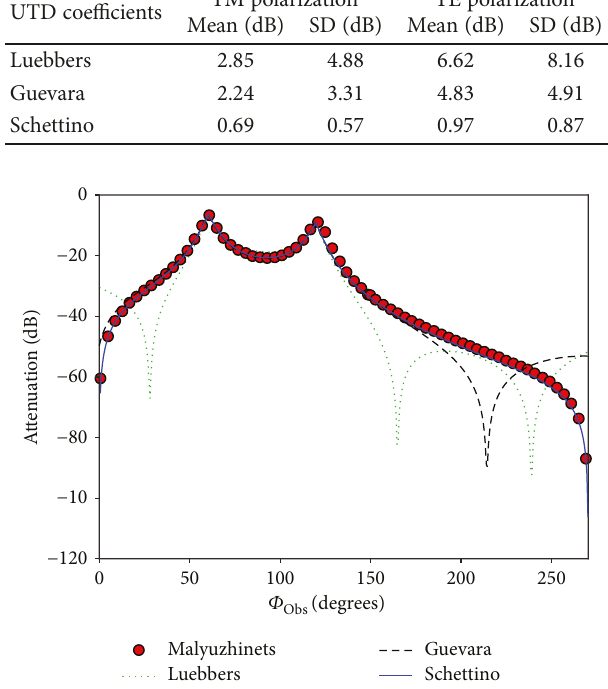
Figure 7: Attenuation of the di ff racted fi eld for TM polarization around the wedge; n -face incidence at ϕ i = 4 π /3 .